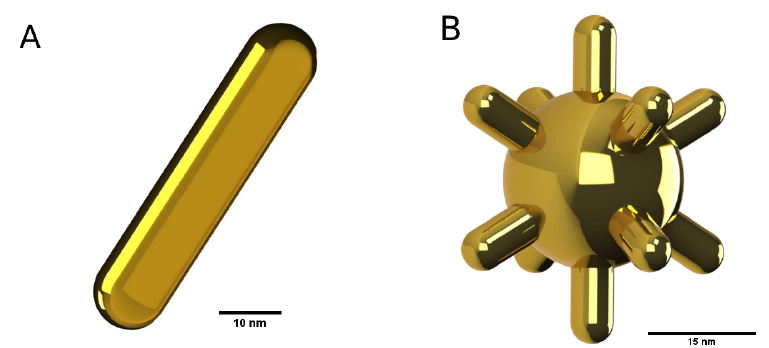
Figure 4. ( A ) Aspect of the NanoRod and ( B ) NanoStar geometries once built.